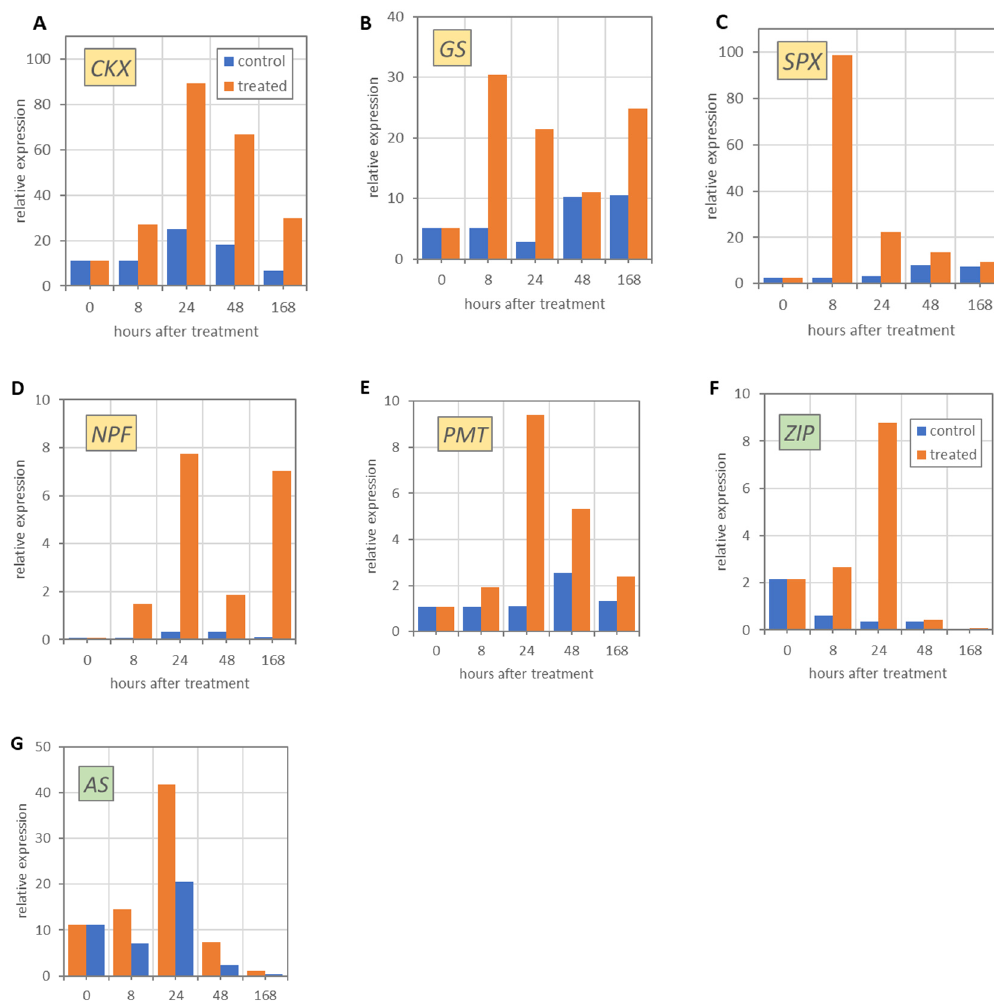
represented by the bars in the graphs on the right (numbers of contigs in the test/reference sets are reproduced next to each bar).